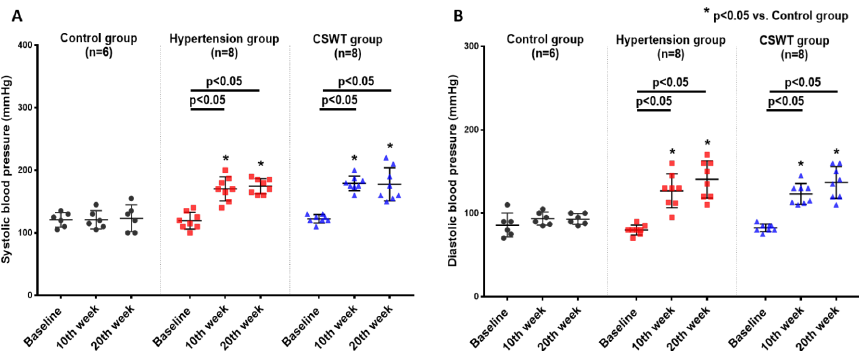
Figure 1. CSWT (cardiac shock wave therapy) effect on blood pressure in hypertensive cardiomyo- pathy. Serial changes to ambulatory blood pressure at baseline, 10th week and 20th week follow-up in control, hypertension and CSWT groups. ( A ). 10 weeks after induction of hypertension, systolic blood pressure of animals significantly increased in hypertension and CSWT groups compared with control group. At the 20th week, CSWT did not reduce the systolic blood pressure compared with hypertension group. ( B ). Diastolic blood pressure in hypertension and CSWT groups was particularly elevated at the 10th week after induction of hypertension. At the end of the experiment, no significant decrease of diastolic blood pressure was observed in CSWT group compared with hypertension group. Two-way repeated ANOVA with Tukey’s test was used, * p < 0.05 versus control group. Int. J. Mol. Sci. 2022 , 22 , x FOR PEER REVIEW